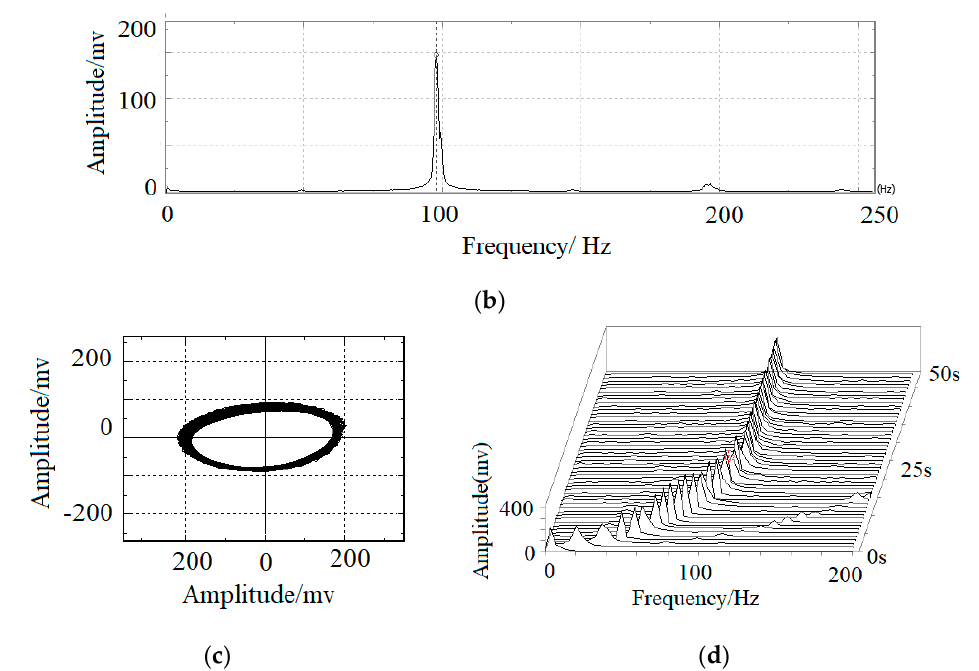
Figure 11. Dynamic response of the floating ring system (test result), when λ = 0.01 and speed ratio is S = 1: ( a ) time-domain waveform; ( b ) the FFT spectrum of rotor; ( c ) axis trajectory; ( d ) waterfall diagram .